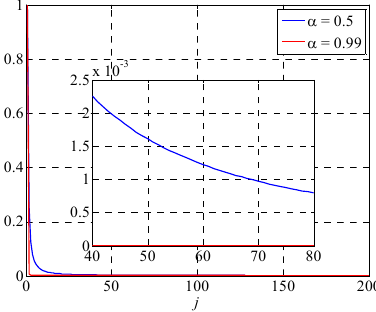
Figure 1. Recursive calculation of weighed coefficient.